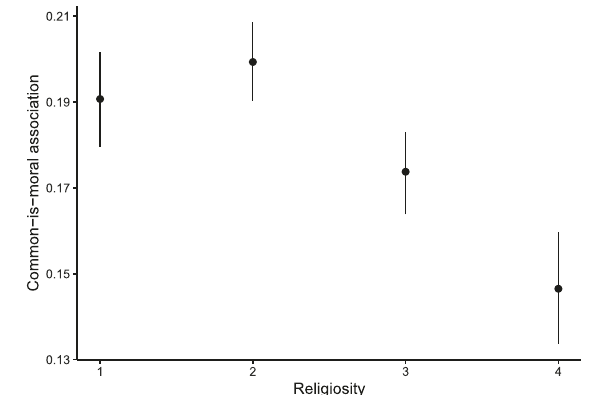
Fig. 2 How the within-individual common-is-moral association depended on religiosity. The graph shows the mean value, with a 95% bootstrap con fi dence interval, of the within-individual common-is-moral association in four subsamples of participants de fi ned by their response to the importance of religion (1 = not at all important, 2 = not important, 3 = quite important, 4 = very